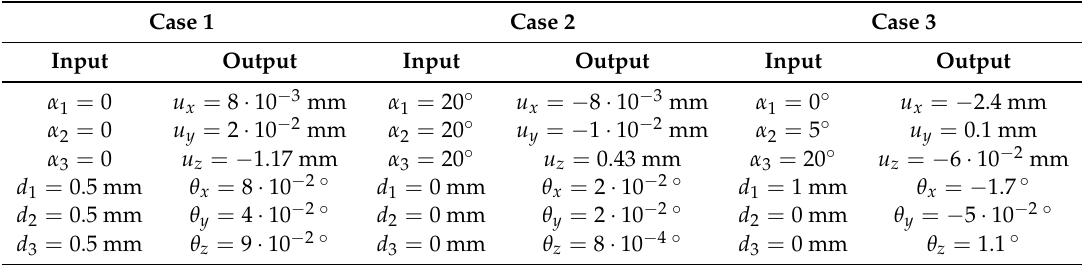
Figure 6. ( a ) Platform displacement along the z -axis, positive direction (Case 2); ( b ) platform pose for a generic actuation scheme (Case 3). Table 1. Input rotations and displacements and their effect on the platform for the three analyzed